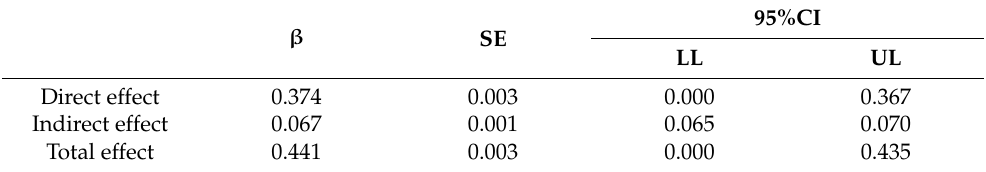
Table 3. Direct effect, indirect effect, and total